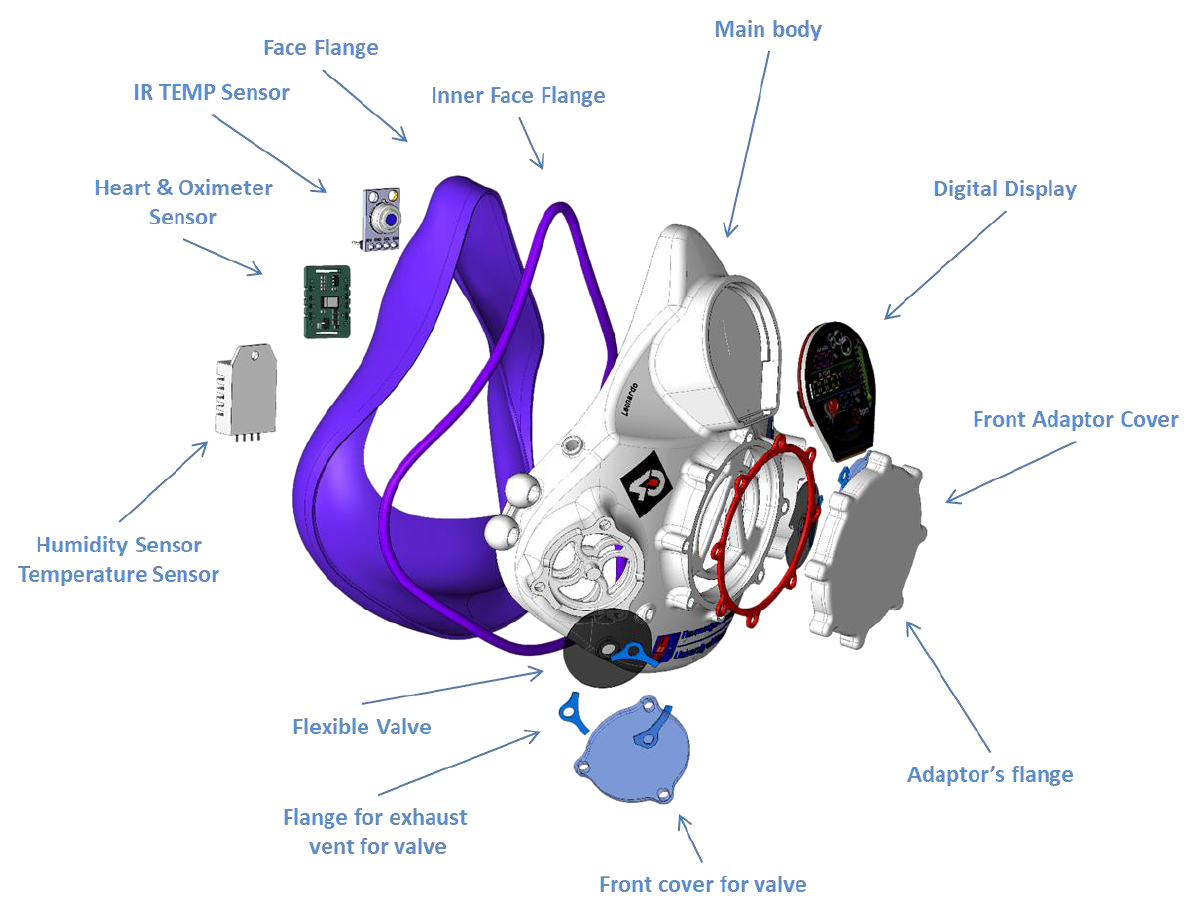
Figure 1. Schematic representation of the basic mask components and assembly.